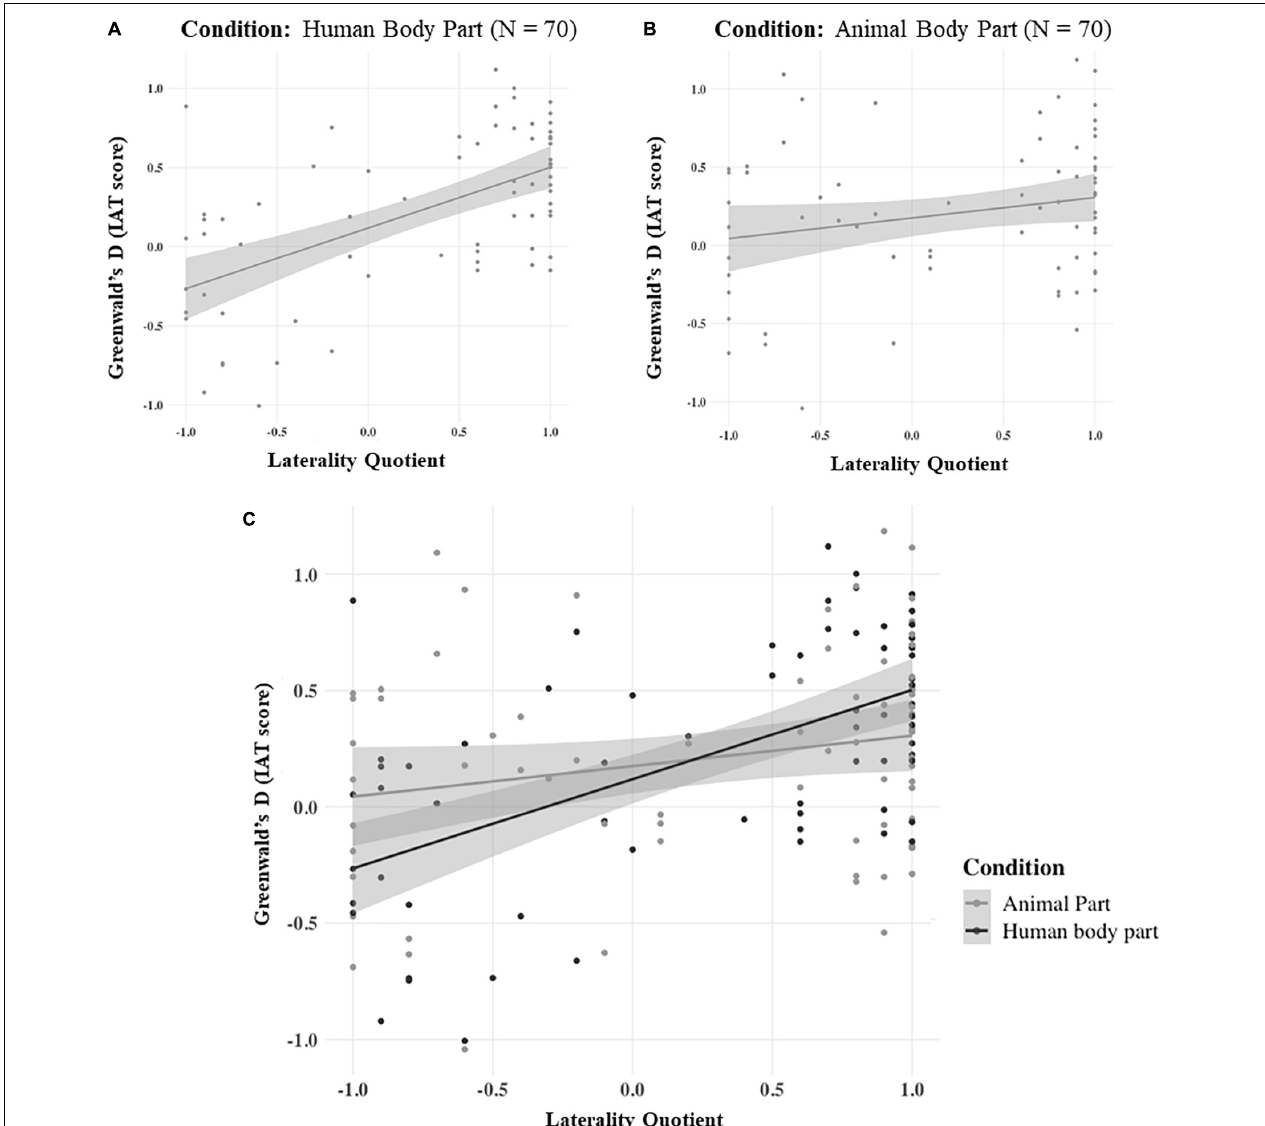
FIGURE 3 | The linear relationship between the Greenwald’s d, on the Y axis, and the Laterality Quotient, on the X axis, in the Human Body Part (A) , Animal Body Part (B) , and Combined (C) conditions. The gray shade near each line represents the standard error of the respective